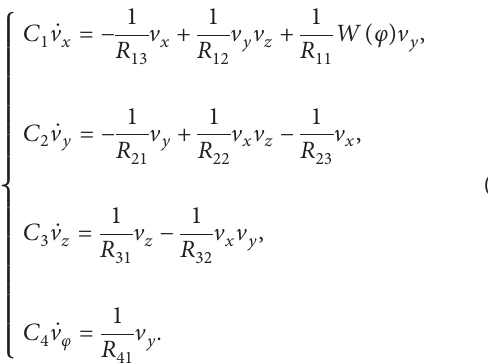
� R � 100 k Ω . Figure 12 gives the phase trajectories R 43 11 shown in the oscilloscopes.